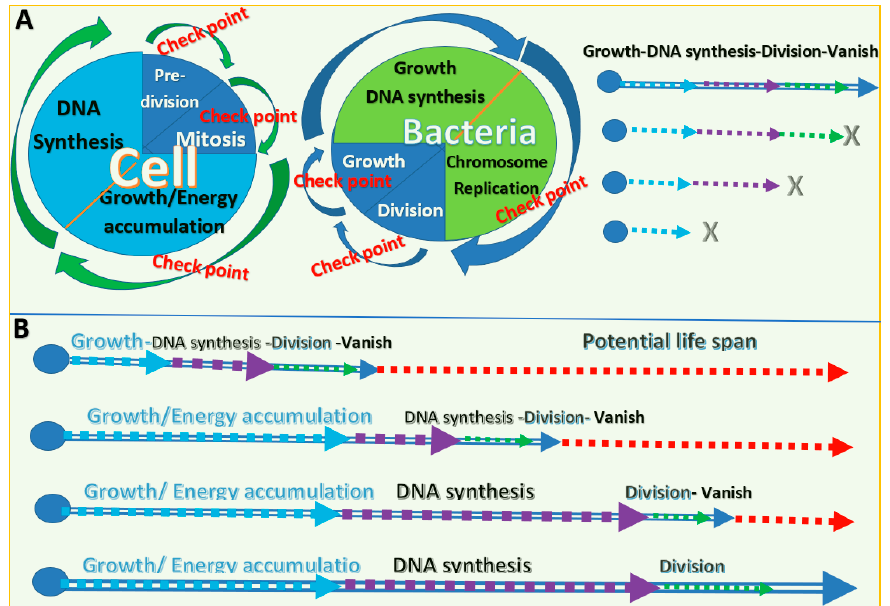
Figure 1. Life cycle and lifespan of a single cell. ( A ) The stages of the life cycle and check points for stopping the life cycles of a cell and bacteria. X indicates the abolishment or stopping of a development stage of a life cycle. ( B ) Possible methods to increase the lifespan of single cells. Different life stages are represented by arrows of different colors. Elongated arrow bars indicate the possible extension of a life stage. Red arrows indicate the potential maximum lifespan of the single